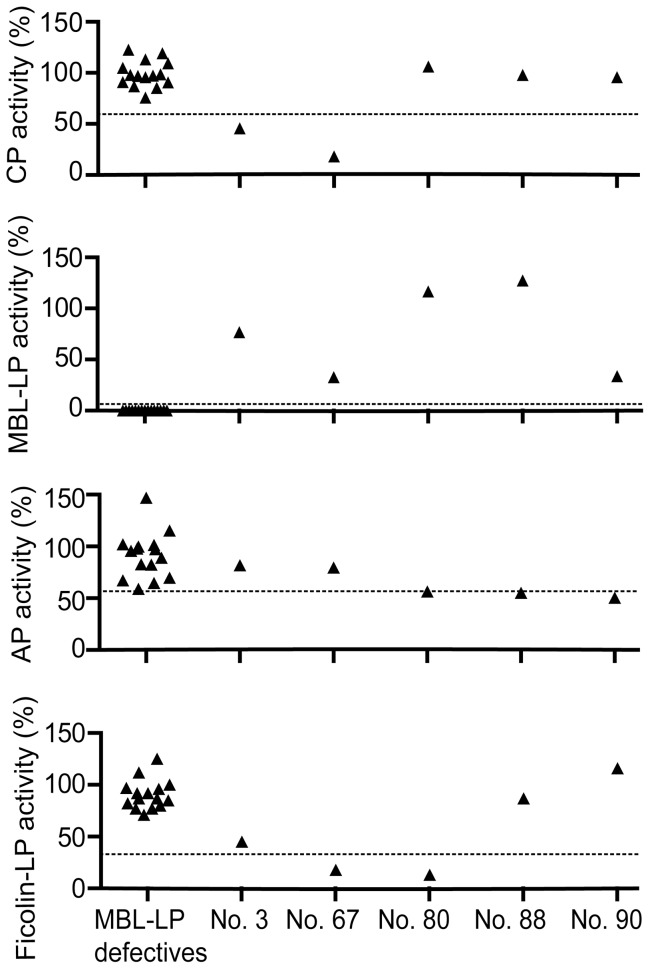
Comparative activity analysis of CRS patients with a potential defect.A lack of functional capacity of the MBL lectin pathway in 15 patients was observed. Patient no. 3 was slightly below the cut-off value in the classical pathway. Patient no. 67 was substantially below the cut-off value in both the classical and Ficolin lectin pathway. The lowest Ficolin lectin pathway activity was measured in patient no. 80, who together with patient no. 88 and 90 had alternative pathway activities marginally below the cut-off value.